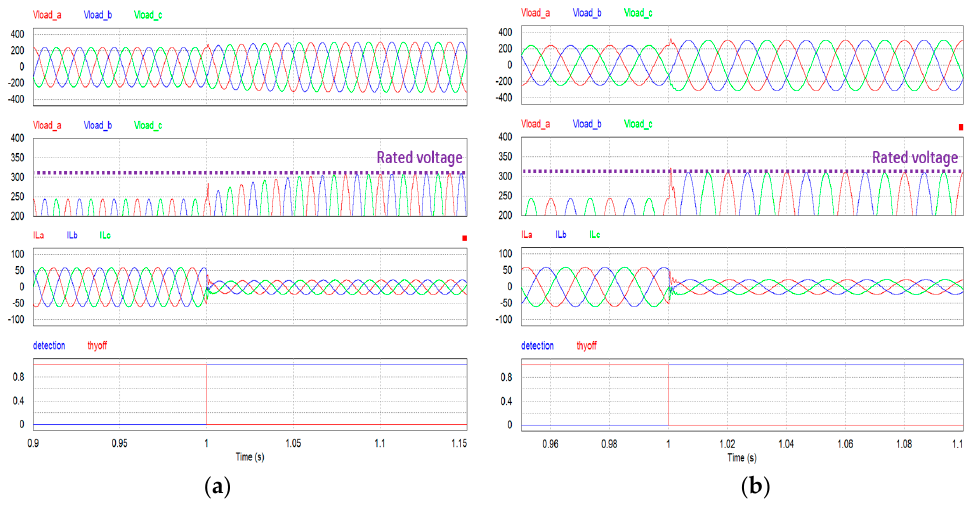
Figure 15. Simulation results of mode switching in the case of low-grid voltage during battery charging: ( a ) using the general inverter controller; ( b ) using the proposed load current compensation controller.